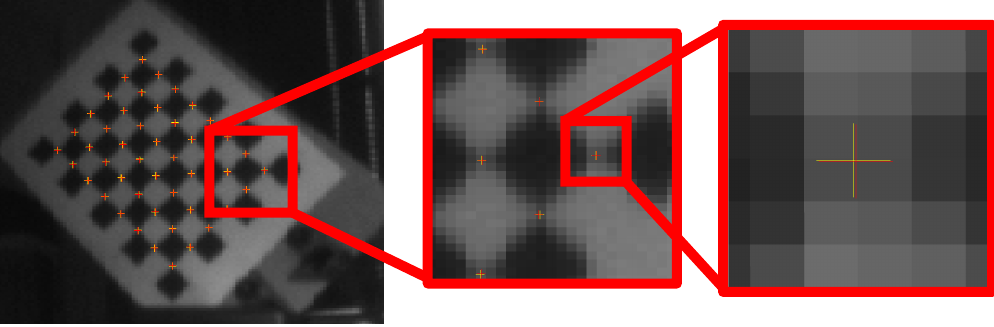
Figure 6. Example of grid re-projection on the image after the optimization process. Sensors 2018 , 18 , x